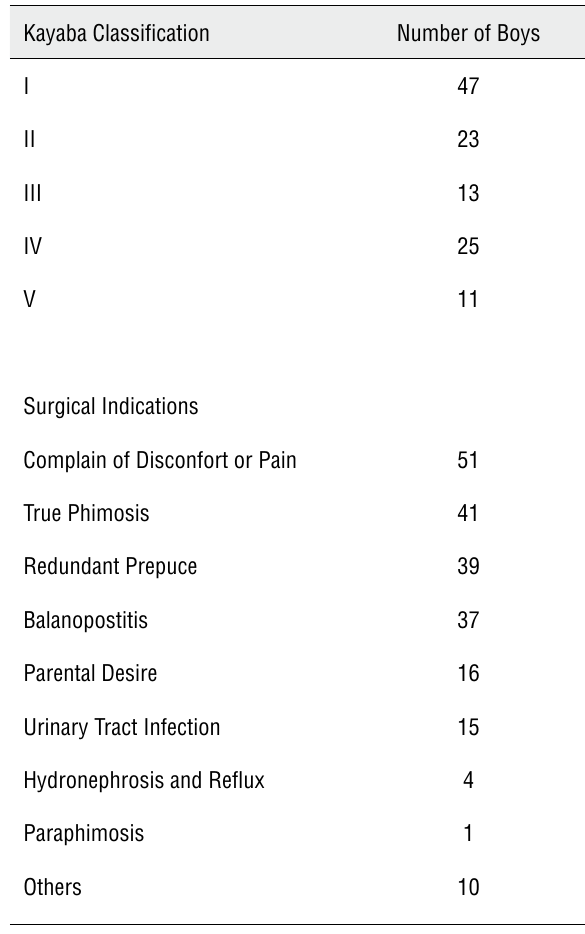
Table 1 - Kayaba Classification and Surgical